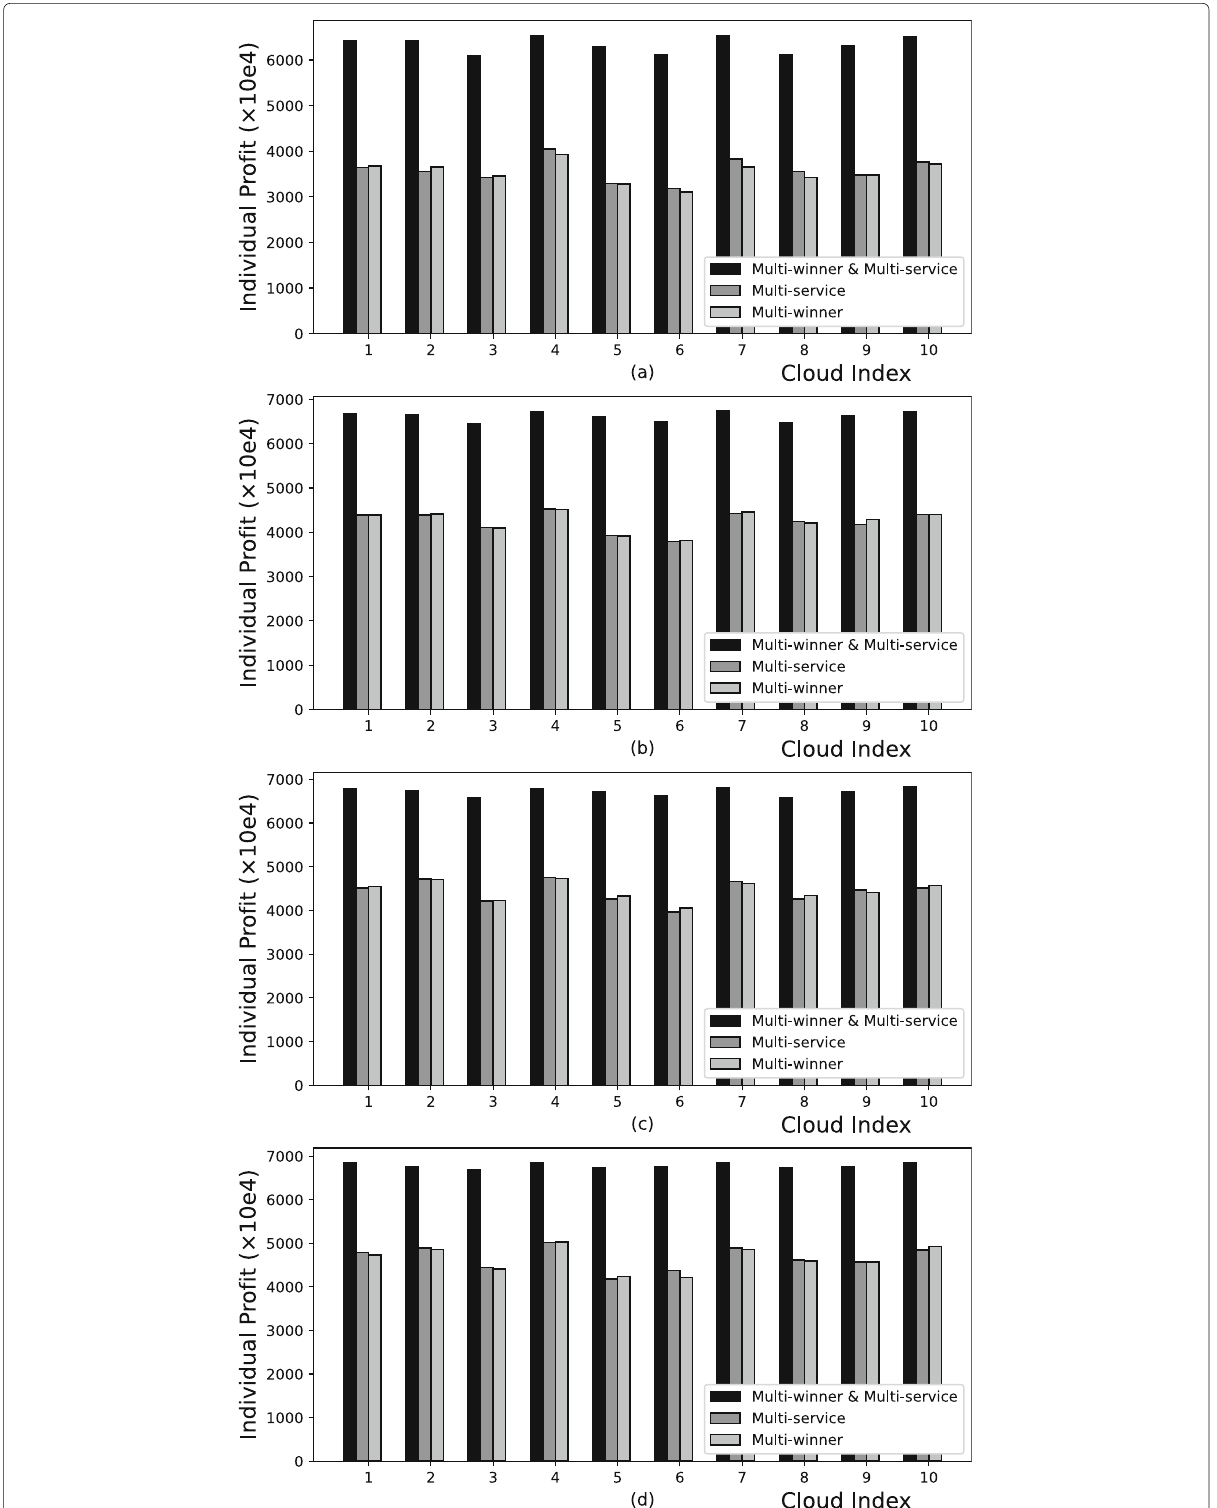
Fig. 9 Comparison of individual profits with different values of V . (a) V = 0.5 × 10 5 , (b) V = 2 × 10 5 , (c) V = 3.5 × 10 5 , (d) V = 5 × 10